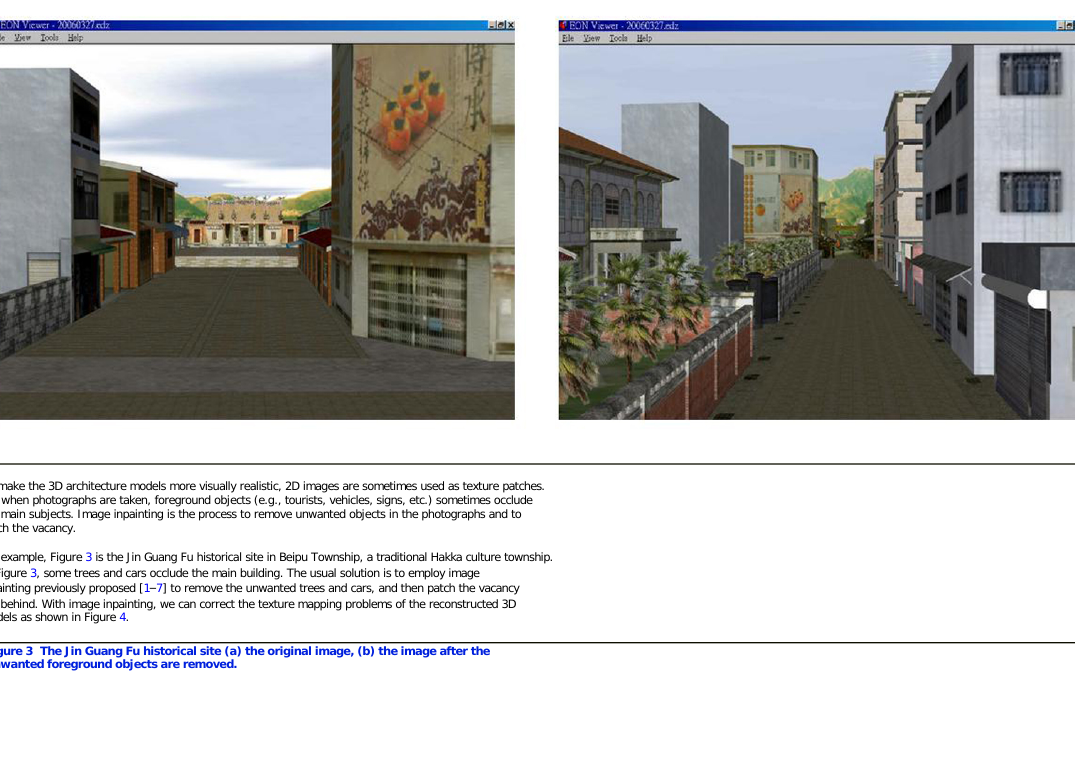
Figure 2 Virtual reality simulation walkthrough of Beipu historical